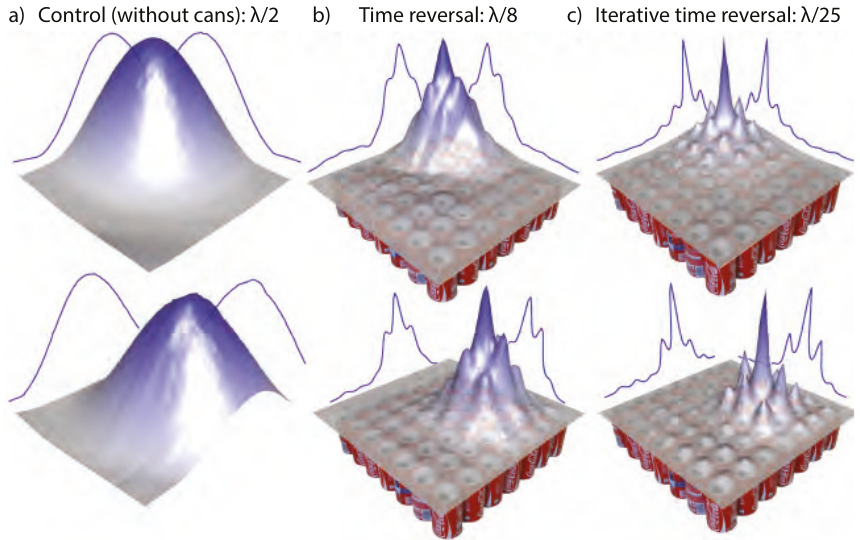
Figure 4. Sub-diffraction focusing of sound. ( a ) Diffraction limited focal spots obtained using time reversal without the array of cans; ( b ) The foci obtained using time reversal onto the same locations with the array of Helmholtz resonators; ( c ) Foci obtained with inverse filter signals demonstrating focal spots as thin as λ